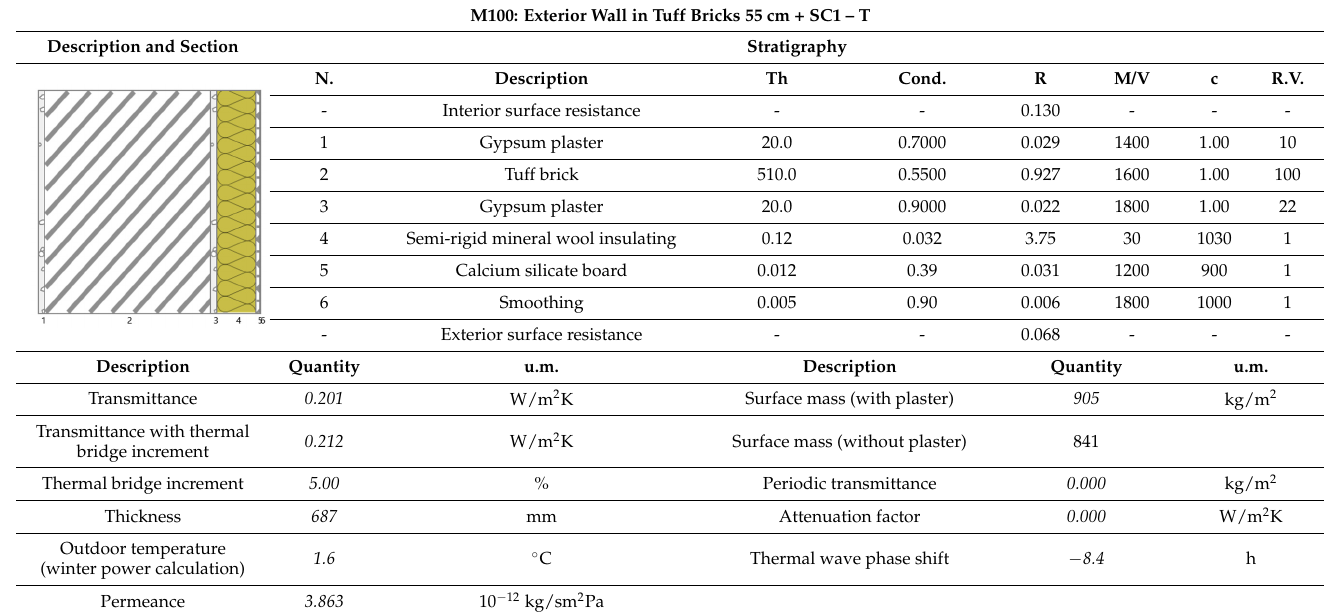
Table 6. M100: exterior wall in tuff bricks 55 cm + SC1; post operam; features. M100: Exterior Wall in Tuff Bricks 55 cm + SC1 – T